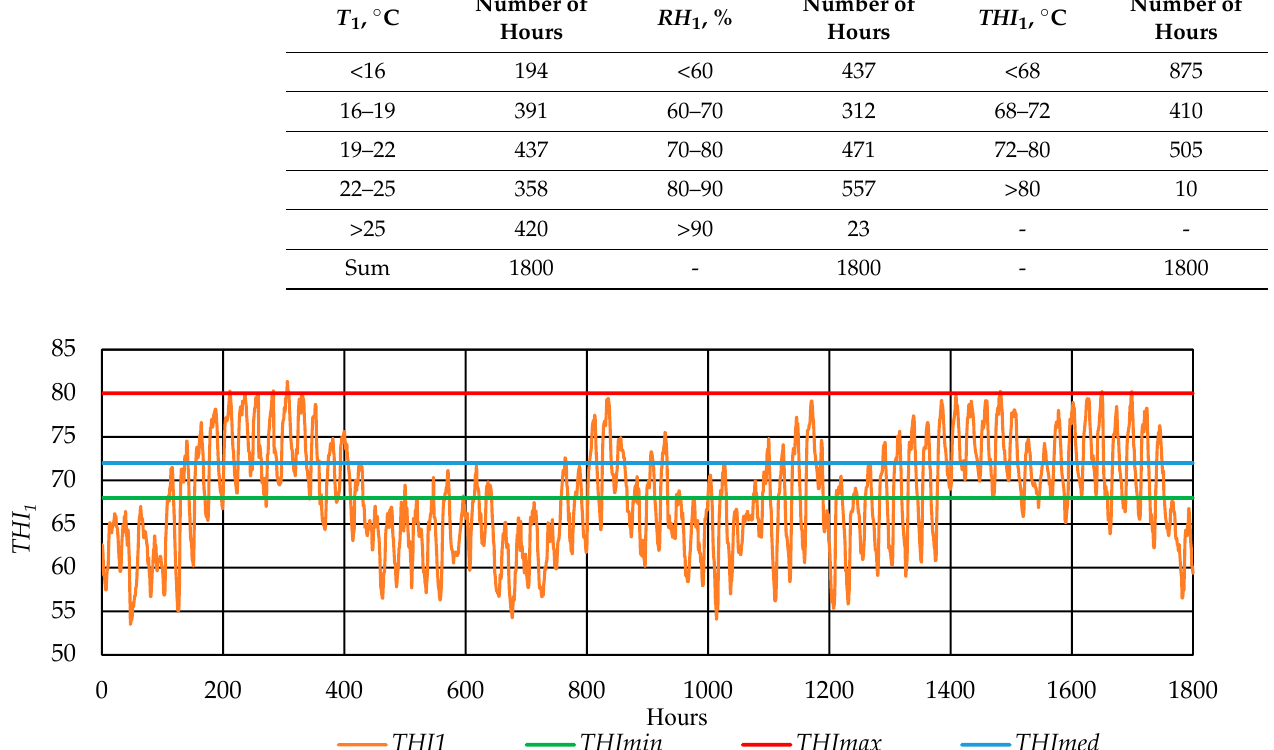
Table 1. Values (indicators) of temperature ( T 1 ), relative humidity ( RH 1 ) and temperature humidity index ( THI 1 ) of the air entering the cowshed from outside.